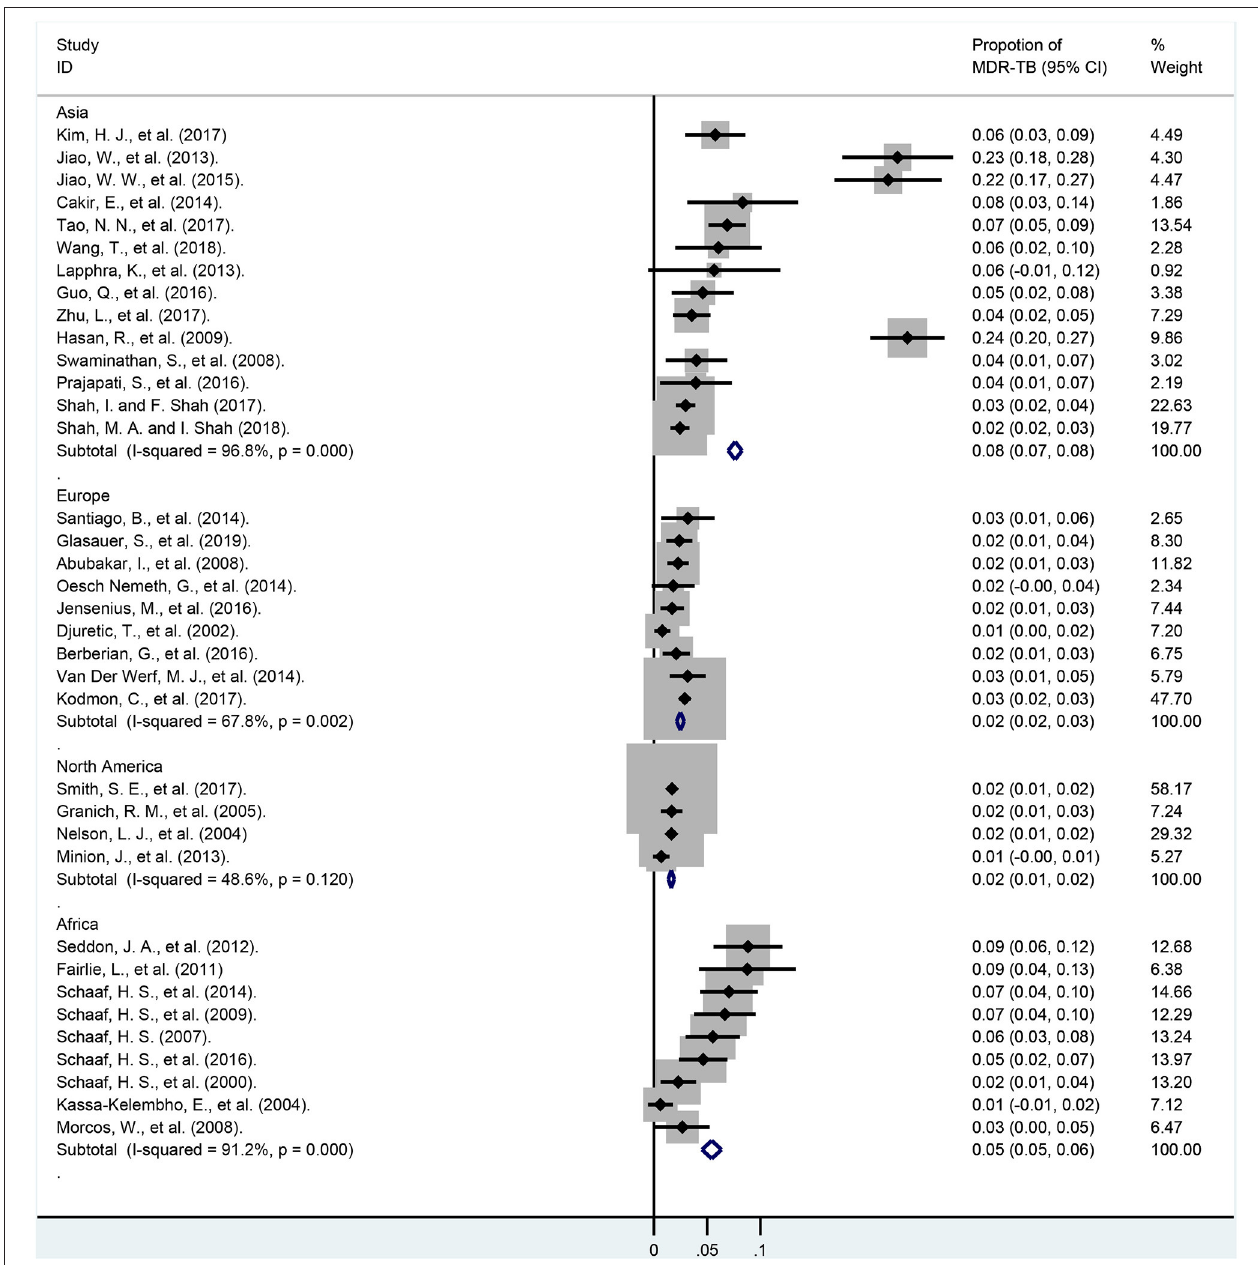
FIGURE 5 | Forest plots for multidrug-resistant tuberculosis ratios in different continents. MDR-TB, multidrug resistant tuberculosis; Horizontal lines represent the 95% CIs around the point estimates for each study and the gray shaded areas are proportional to the weight given to each study.